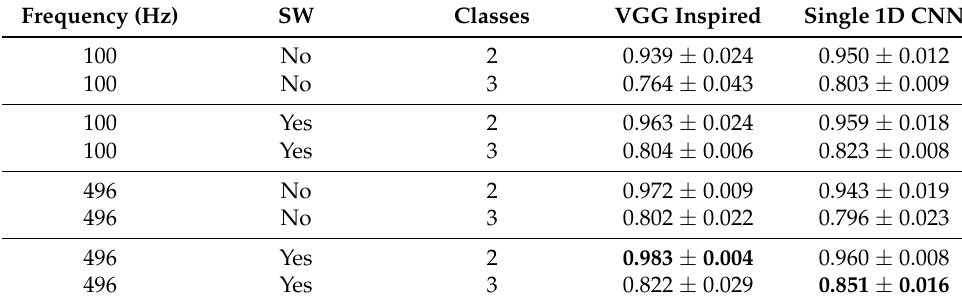
Table 4. Models’ cross-validation accuracy using different